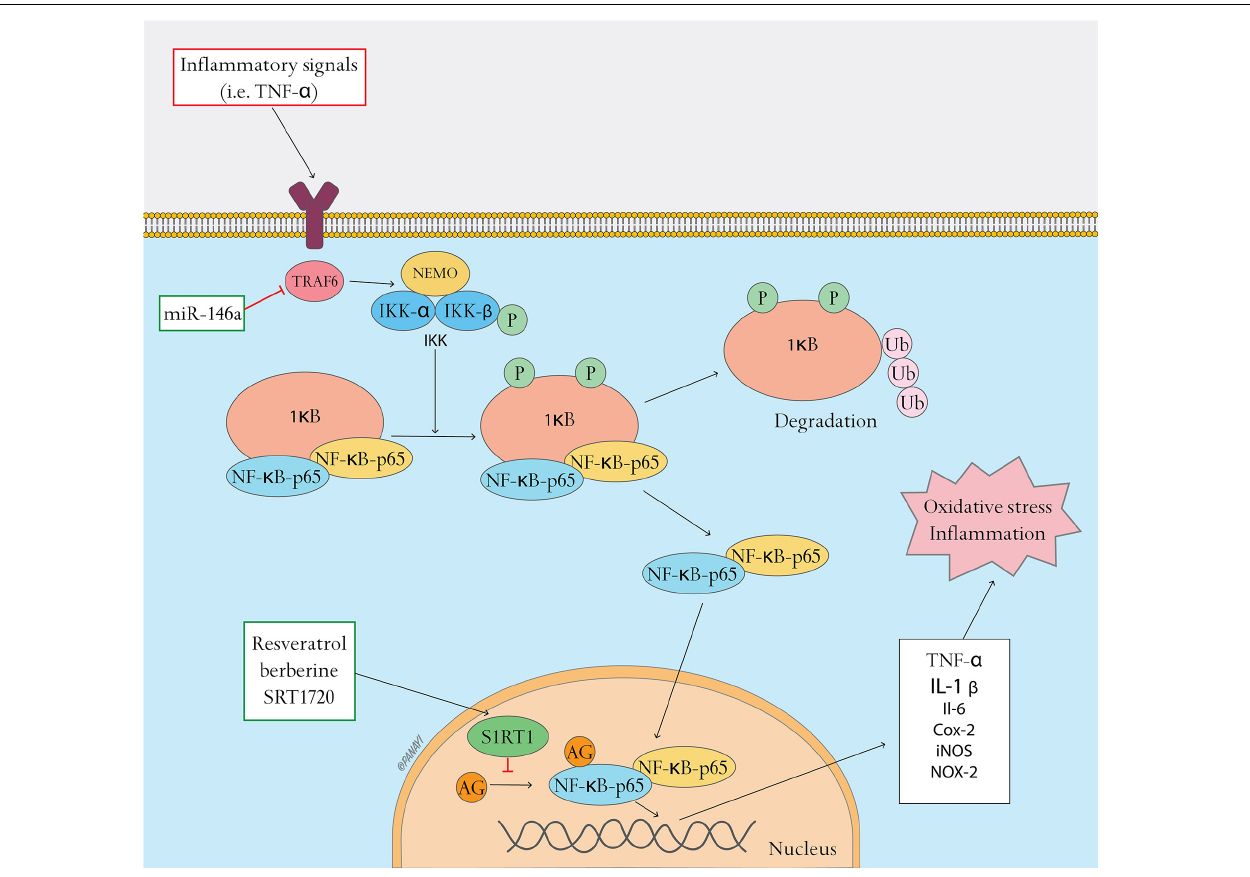
FIGURE 2 | NF κ B pathway and related antioxidant therapy. NF κ B pathway and related antioxidant therapy. This figure shows the activation of the NF κ B pathway and the effects of antioxidant therapy targeting this pathway. In resting state, NF κ B dimers form a complex with the inhibitory protein I κ B, which is located in the cytoplasm. Inflammatory signals (such as TNF- α ) induce phosphorylation of I κ B through upstream kinases (IKK), resulting in the ubiquitination and degradation of I κ B. Active NF κ B translocates to the nucleus and activates target genes including TNF- α , IL-1 β , IL-6, COX-2, iNOS, and NOX-2, resulting in oxidative stress and inflammation. Oxidative stress can be regulated by inhibiting the NF κ B pathway. MiR-146a can target and repress tumor necrosis factor receptor-associated factor 6 (TRAF6), inhibiting the activation of IKK and the NF κ B pathway. SIRT1 activators, such as resveratrol, berberine and SRT1720, suppress binding of NF κ B to inflammation-related gene promoters and their transcriptional activities by activating SIRT1, a NAD-dependent class III histone deacetylase that leads to deacetylation of the p65